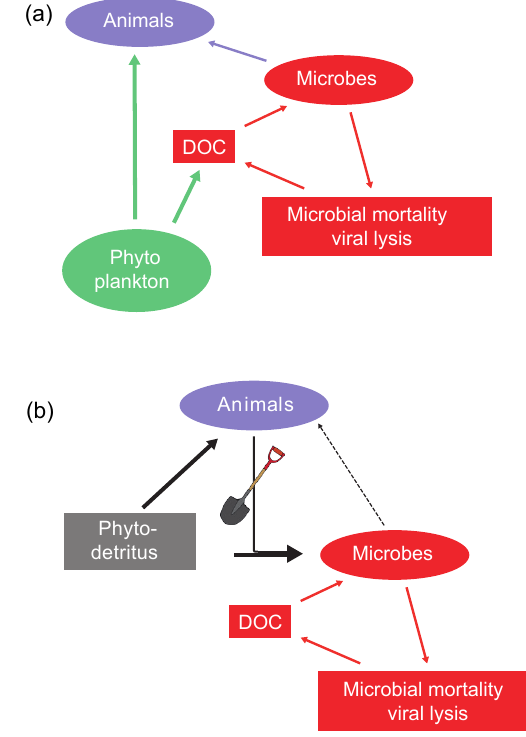
Figure 6. The microbial (a) and inverted microbial (b) loops. In the water column dissolved organic carbon derived from phytoplank- ton, zooplankton or microbes (via viral loop) is consumed by het- erotrophic microbes, which in turn are consumed by protists and small animals, with the consequence that carbon flowing through dissolved organic carbon pools can eventually be used by larger animals (microbial loop). In sediments, the dissolved organic car- bon (from viral lysis and other sources) is also consumed by het- erotrophic microbes but this carbon is inefficiently transferred to animals. The engineering activities of animals are key in deliver- ing labile organic matter (phytodetritus) to microbes living in the subsurface (inverted microbial